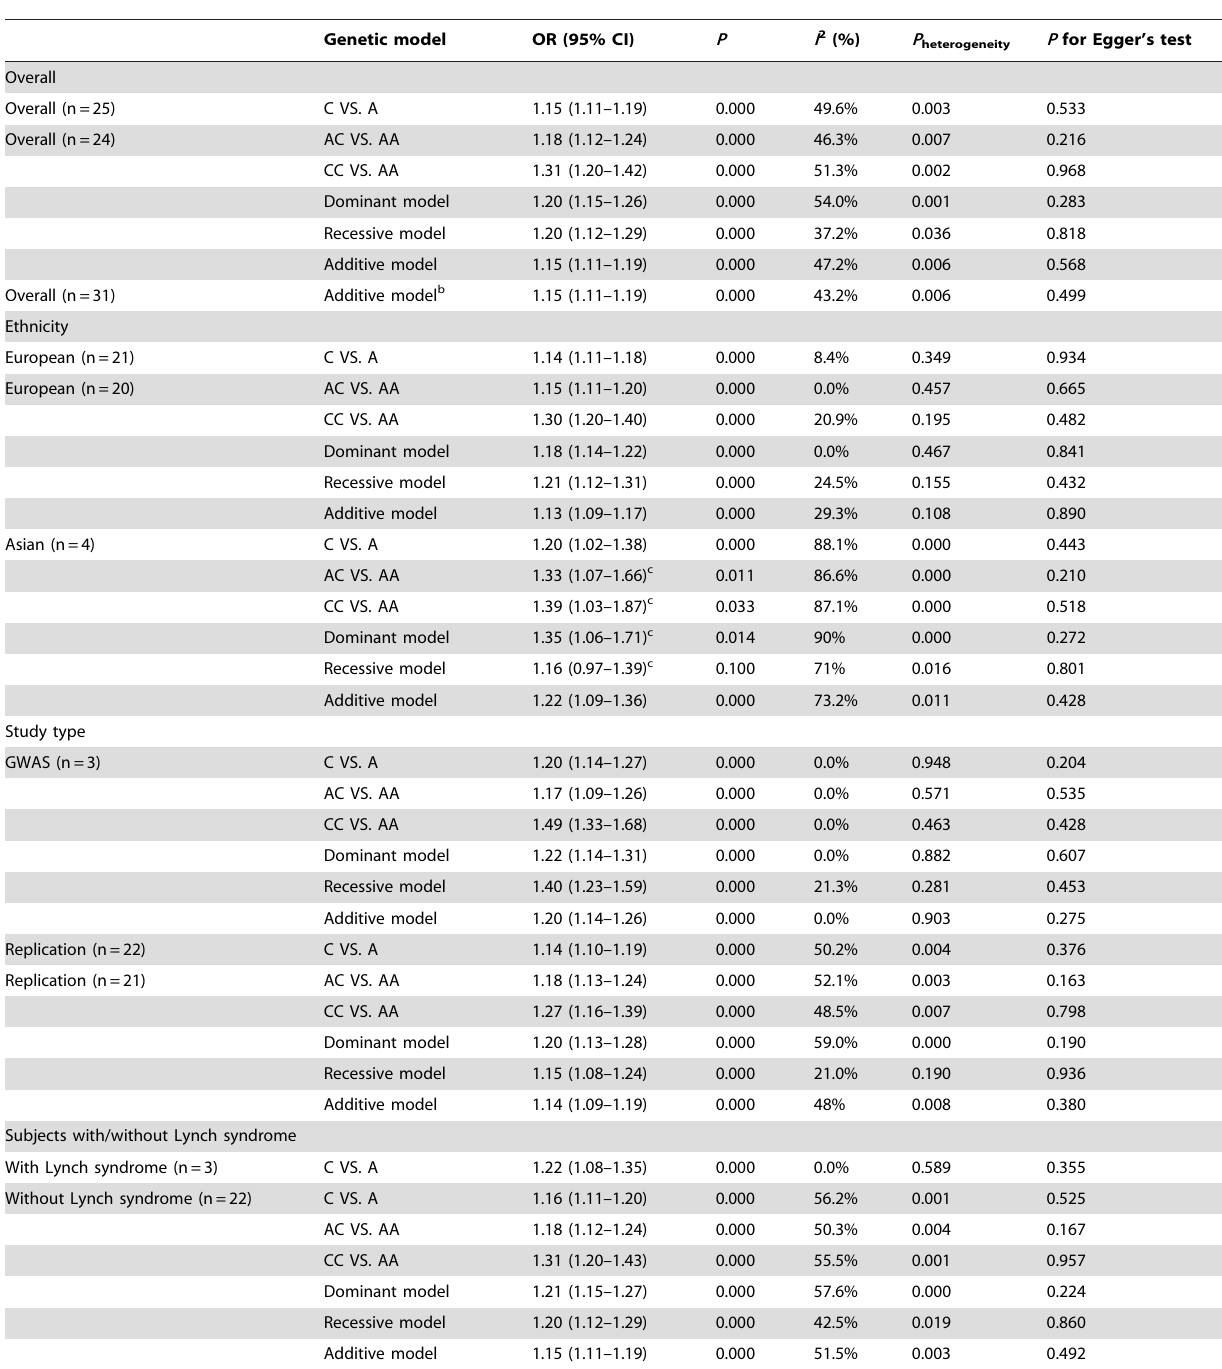
Table 4. Meta-analysis of the rs3802842 in association with colorectal cancer risk a .